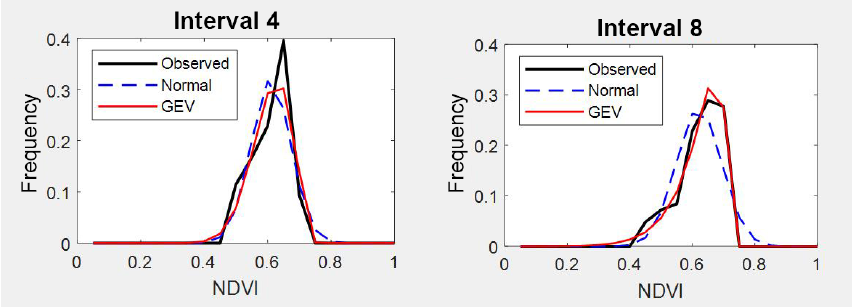
Figure 5. Comparison between observed NDVI frequency, GEV and normal probability density functions (PDFs) on two different dates. Intervals 4 and 8 are examples for winter.